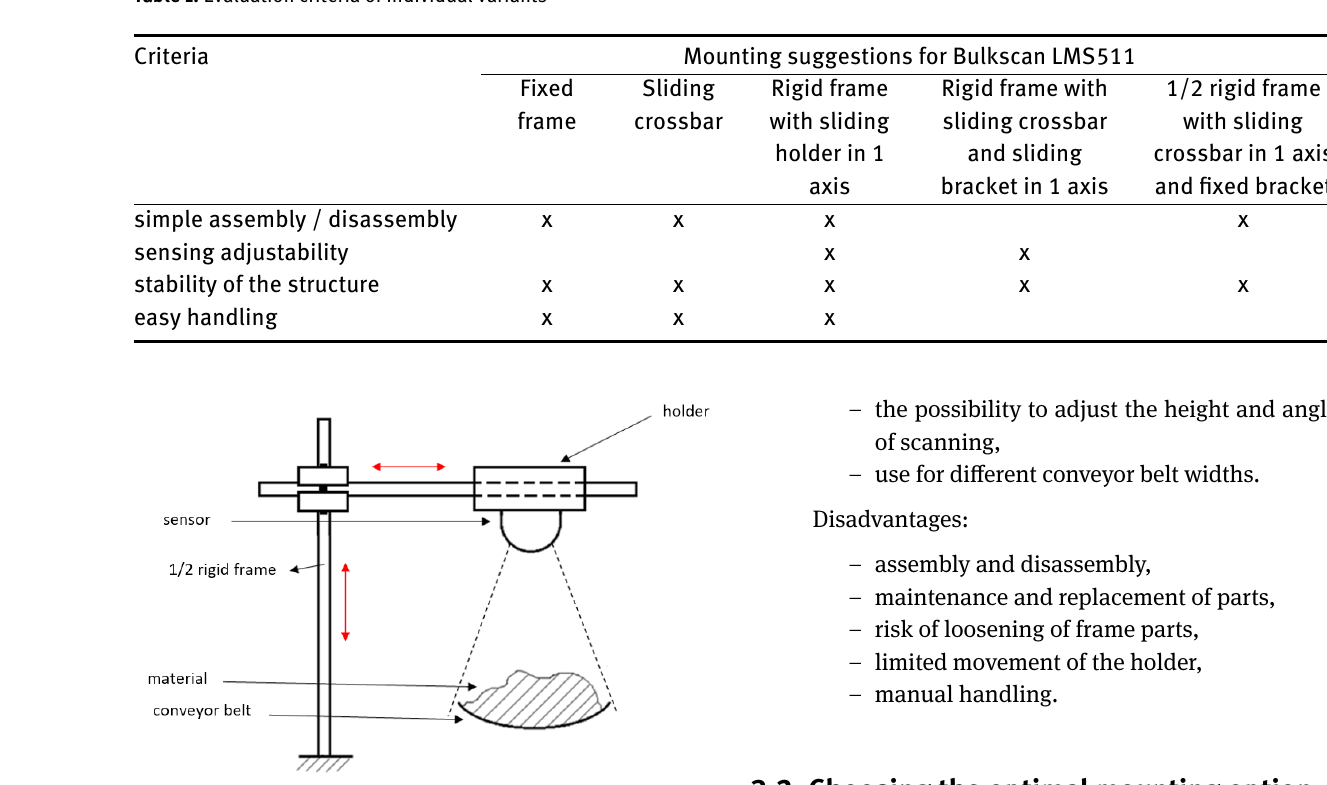
Table 1: Evaluation criteria of individual variants